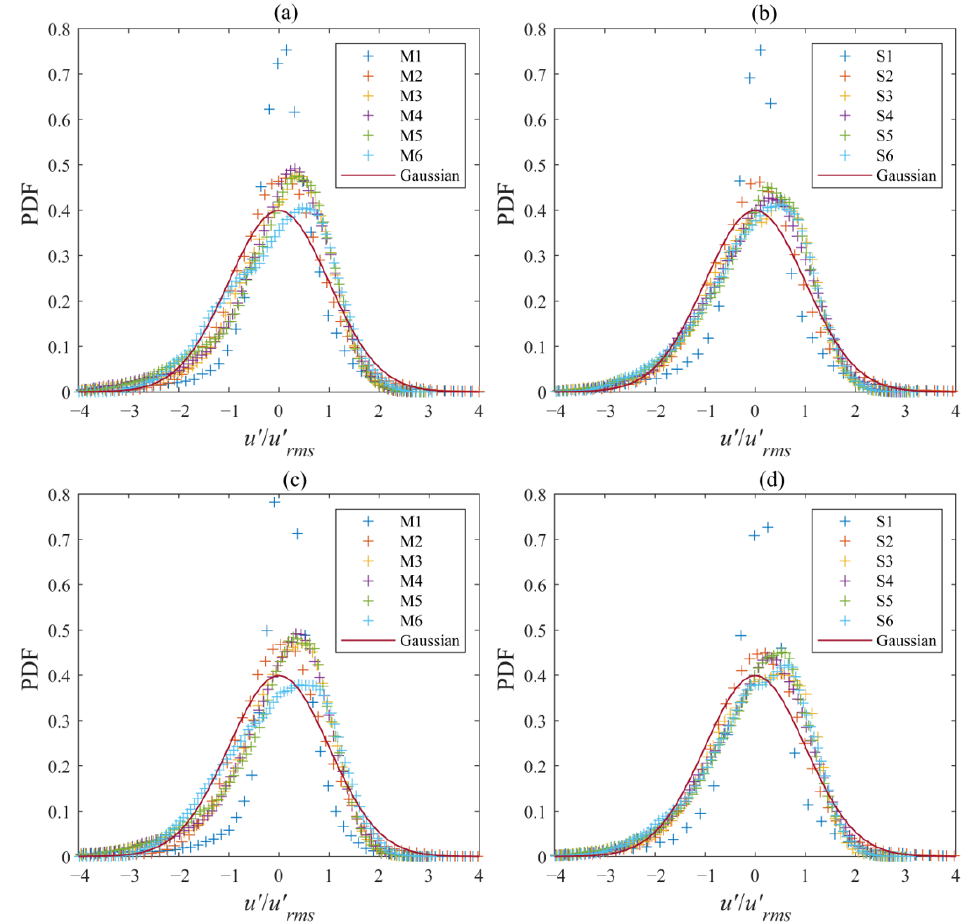
Figure 8. Probability density function (PDF) of streamwise velocity fluctuations at all locations in the vicinity of the spur dike in ( a ) Case 1 at z / H = 0.51, ( b ) Case 1 at z / H = 0.93, ( c ) Case 2 at z / H = 0.51, and ( d ) Case 2 at z / H = 0.93.